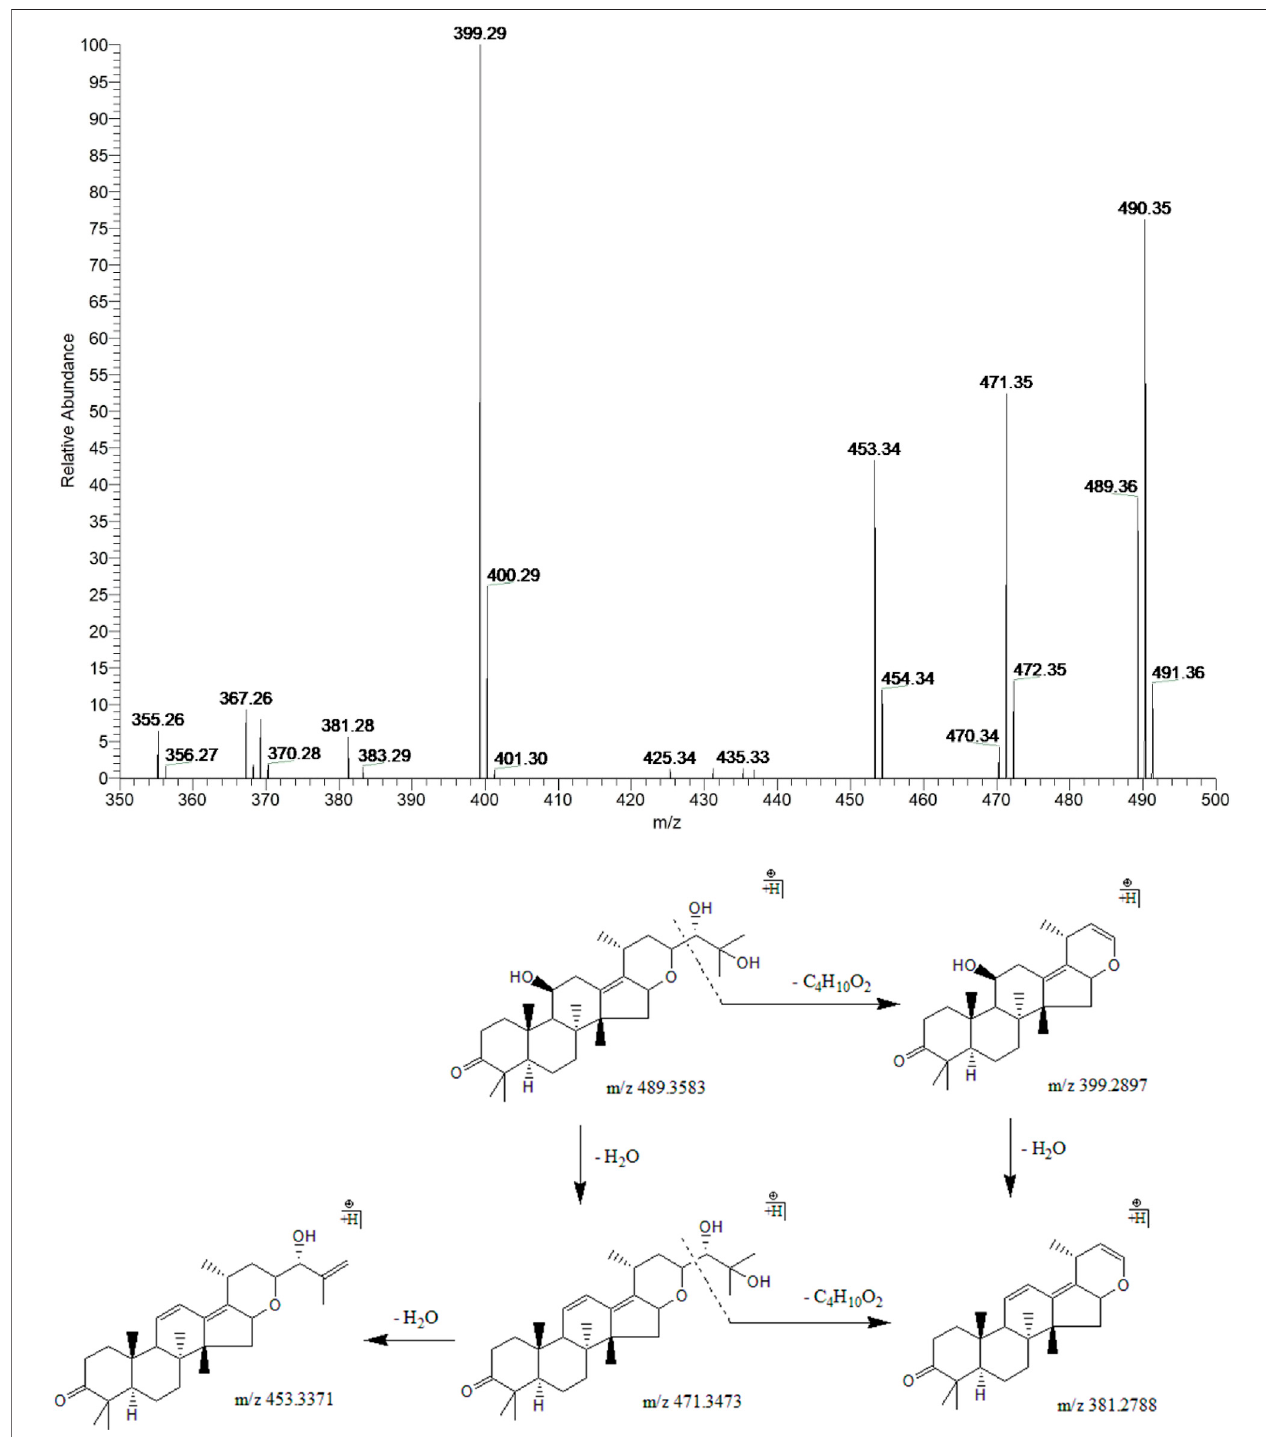
FIGURE 6 | The second-order mass spectrometry graphs and proposed fragmentation pathways of alisol F (peak 14).